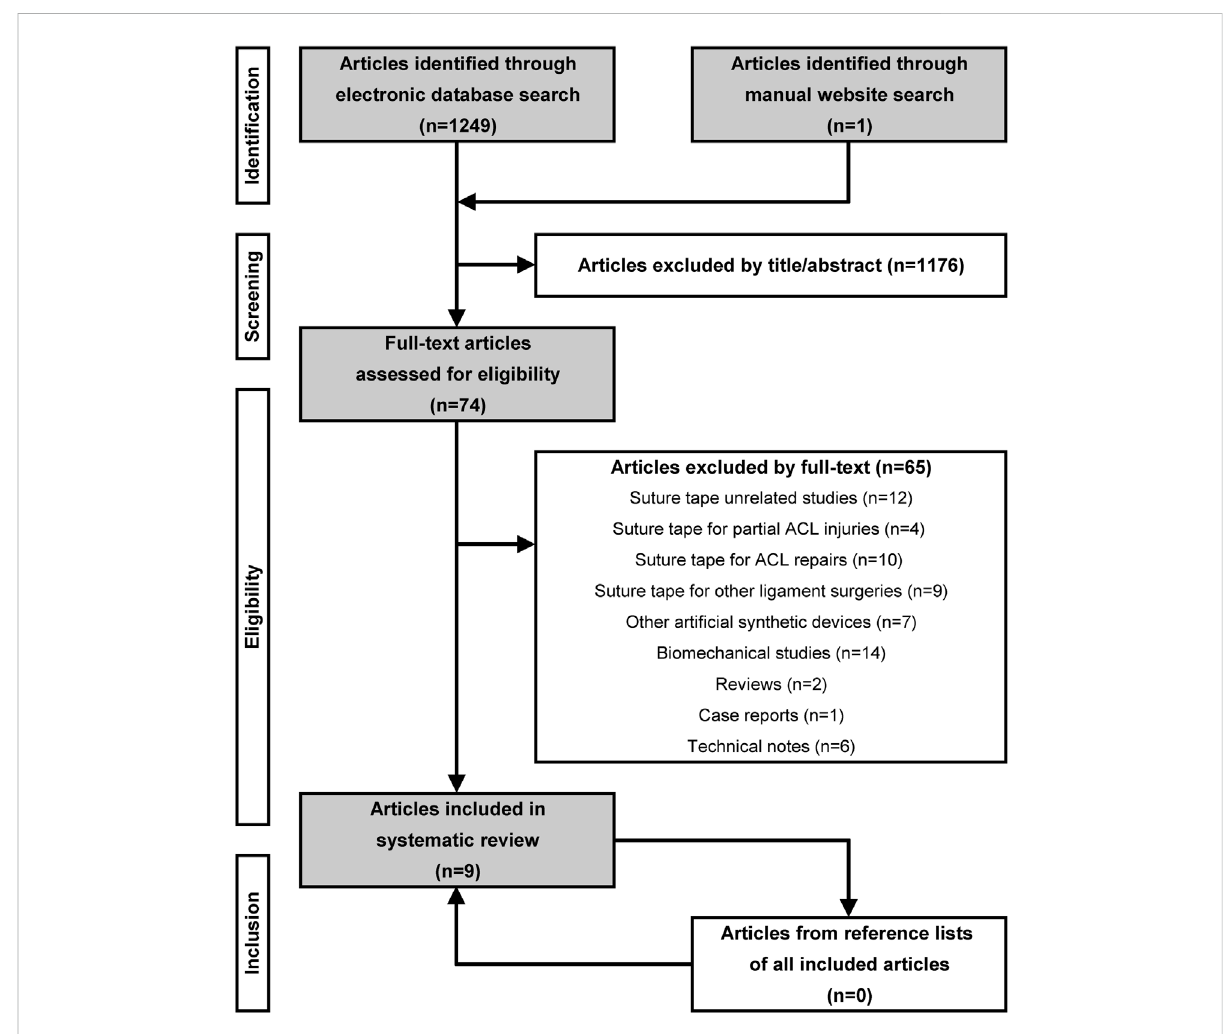
FIGURE 2 Flowchart of search strategy following the PRISMA 2020 statement (Page et al., 2021). ACL, anterior cruciate